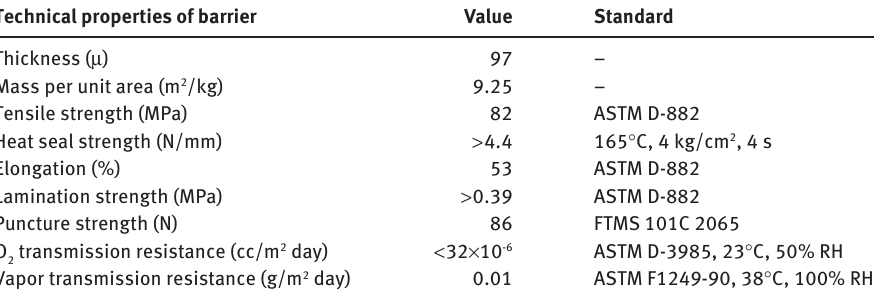
Table 1 Some technical properties of the barrier produced within the scope of the project and used in VIP